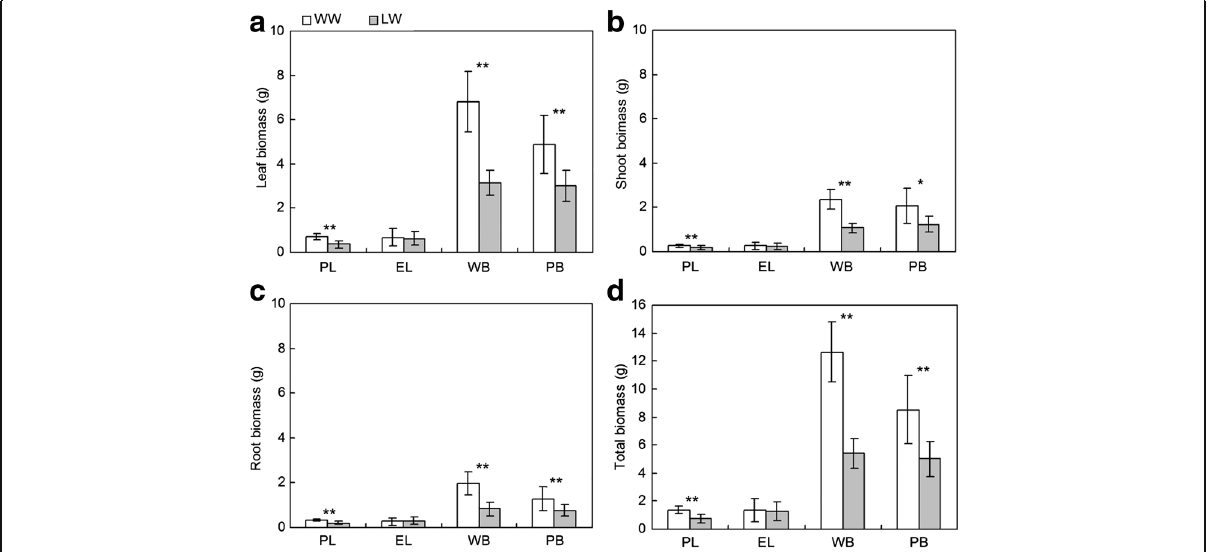
Fig. 3 Seedling biomass (g) of four species treated by two water treatments. a : Leaf biomass (g), b : Shoot biomass (g), c : Root biomass (g), d : Total biomass (g). PL: Prince Rupprecht ’ s larch, EL: eastern larch, WB: white birch, PB: paper birch. WW: well-watered seedlings shown by white bars , LW: low-watered seedlings shown by grey bars. Asterisks above bars indicate significant difference between the two treatments, * difference at P < 0.05, ** difference at P <